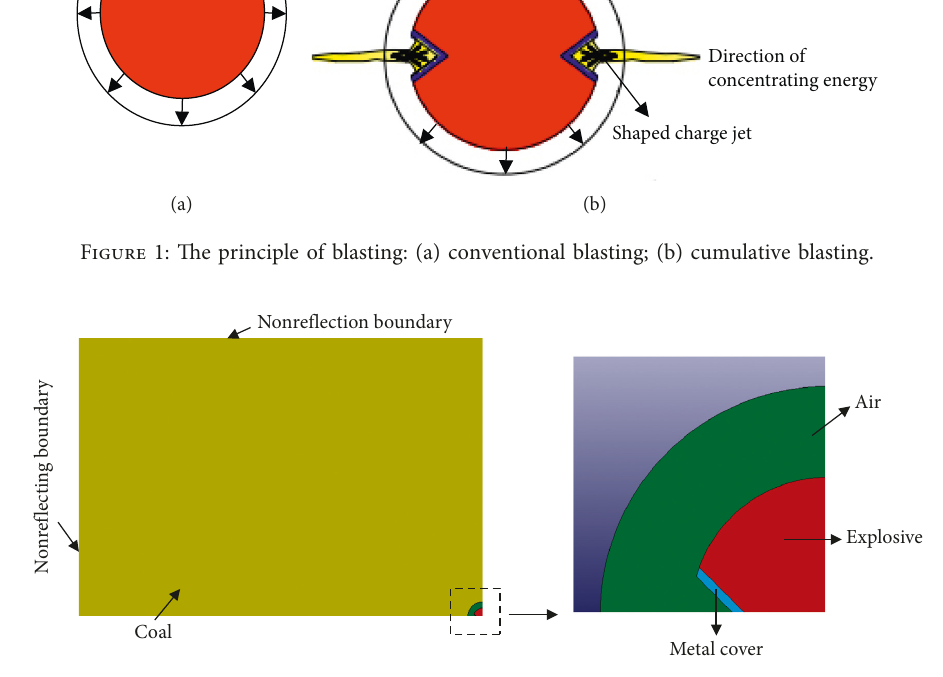
Figure 2: Numerical simulation model of cumulative blasting with decoupling coefficient two. Table 1: Parameters of emulsion explosive.